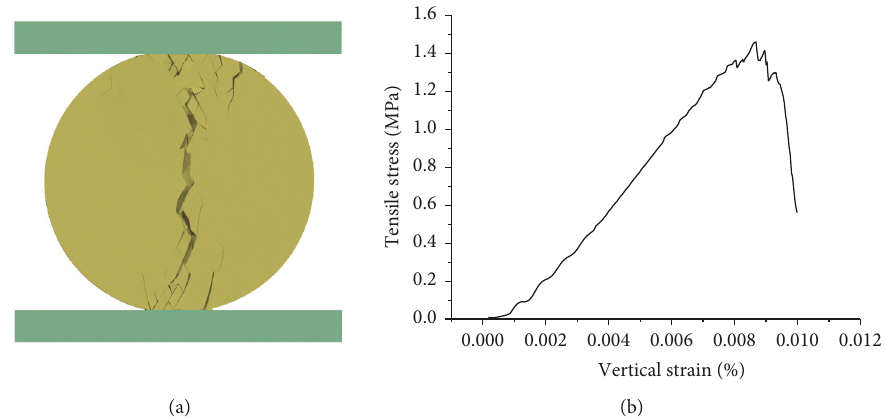
Figure 6: Numerical test result of Brazilian test: (a) fracture mode; (b) stress-strain curve of numerical